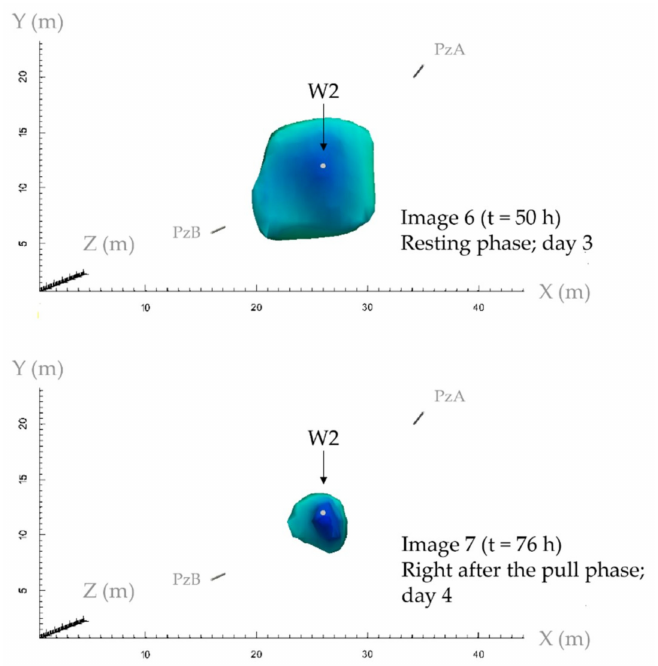
Figure 9. Plain view showing changes in bulk electrical resistivity (view from above) at the end of the resting phase (1st panel, Image 6) and right after the pull phase (2nd panel, Image 7). The same filtering scheme has been